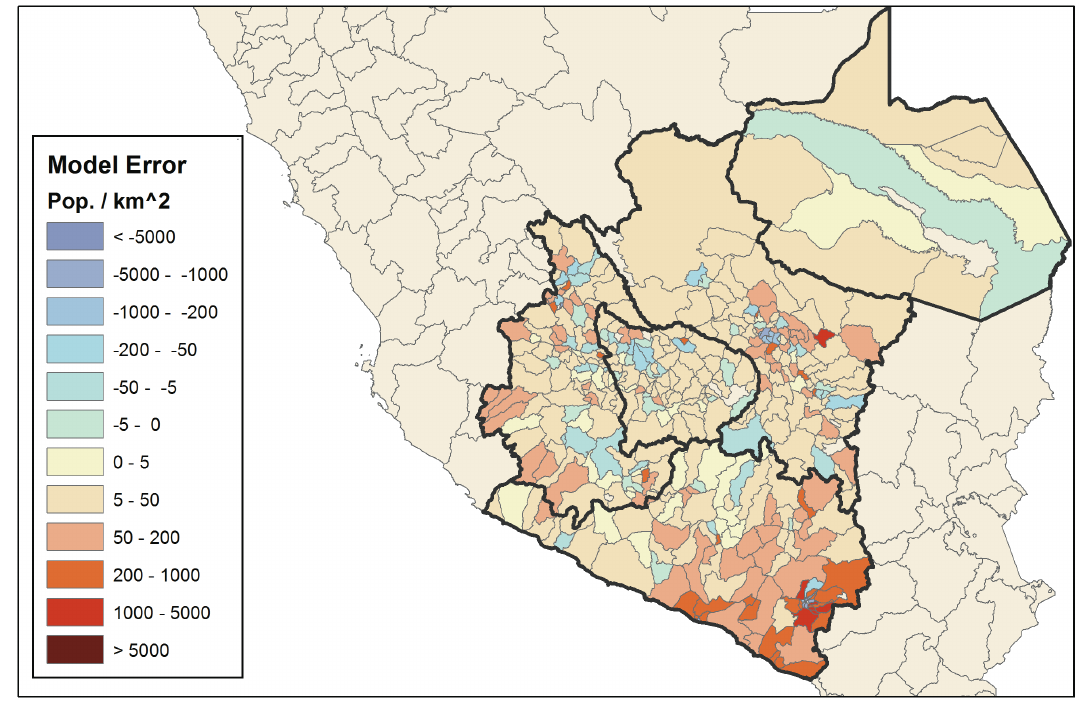
Figure 3. Random Forest model error by district.